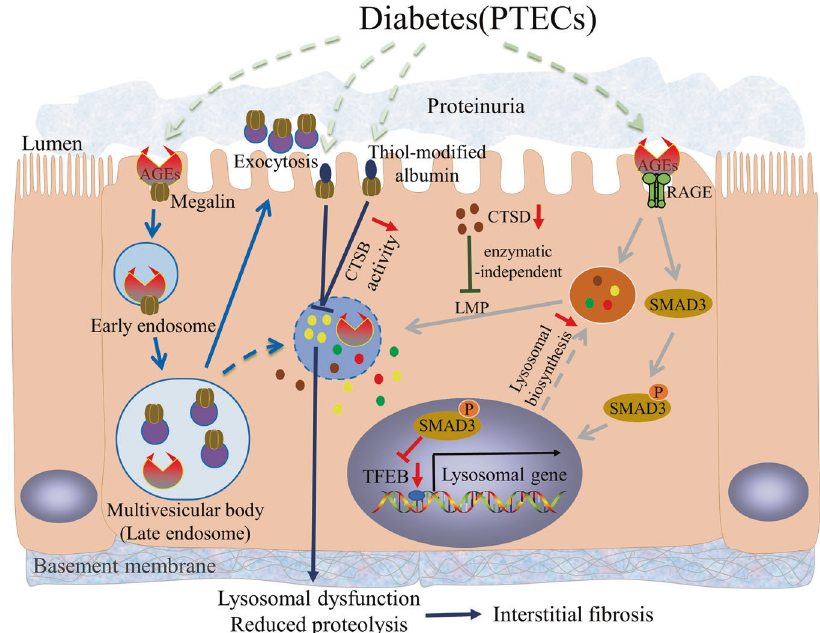
Fig. 3 Mechanism of lysosomal dyshomeostasis and its effect on PTECs during DKD. AGEs can induce LMP through the AGE-RAGE interaction, triggering lysosomal dysfunction and tubular injury 7 . Smad3 binds with TFEB and inhibits its expression, resulting in inhibition of lysosome biosynthesis obstacle 95 . Megalin-mediated uptake of AGEs causes lysosomal dysfunction, leading to increased multivesicular body formation and exocytosis-mediated urinary megalin excretion. Renal PTECs lack protein endocytosis megalin receptors, resulting in proteinuria persistence 104,105 . LMP caused by AGEs can marginally improve by CTSD upregulation, independent of its enzymatic activity 112 . CTSB activity decreases by megalin-mediated uptake of thiol-modi fi ed albumin. Subsequently, the rate of lysosomal CTSB proteolysis is compromised, contributing to renal tubulointerstitial fi brosis 119 . AGEs, advanced glycation end products; CTSB, cathepsin B; CTSD, cathepsin D; DKD; diabetic kidney disease; LMP, lysosomal membrane permeabilization; PTECs, proximal tubular epithelial cells; RAGE, AGE receptor; TFEB, transcription factor